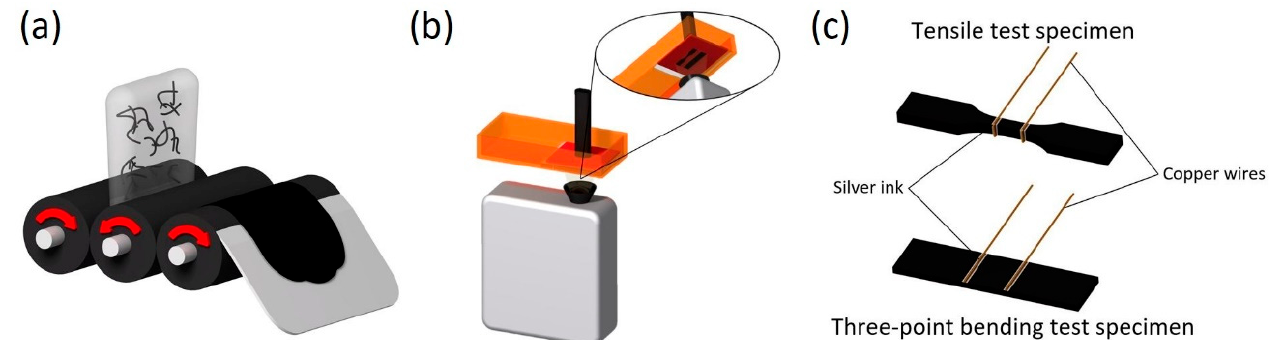
Figure 1. Manufacturing process of the nanocomposite specimens: ( a ) calendering dispersion process, ( b ) DLP 3D printing process and ( c ) electrode placement on 3D printed specimens.